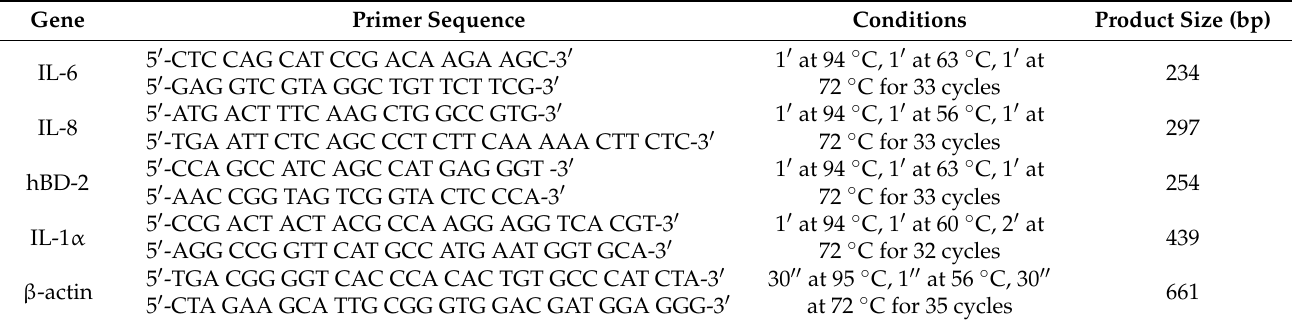
Table 5. Sense and antisense primers of the five gene sequences showing sense (upper row) and antisense strands (lower